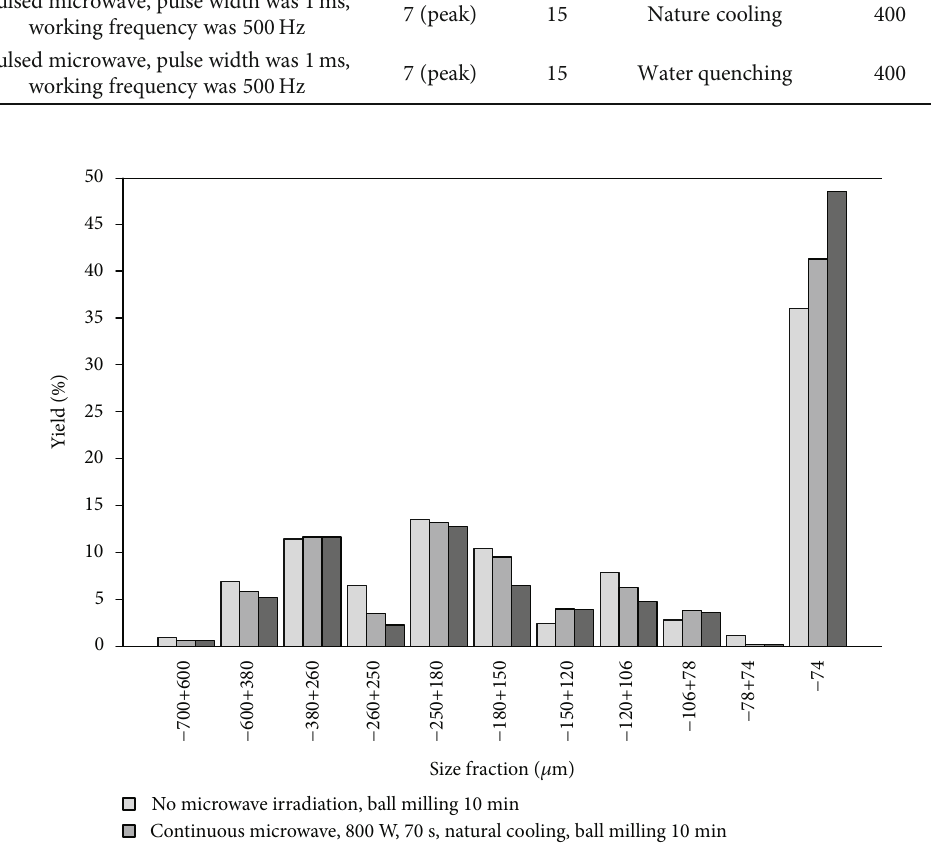
Figure 4: E ff ect of continuous microwave pretreatment on size fraction distribution of grinding products for lead-zinc